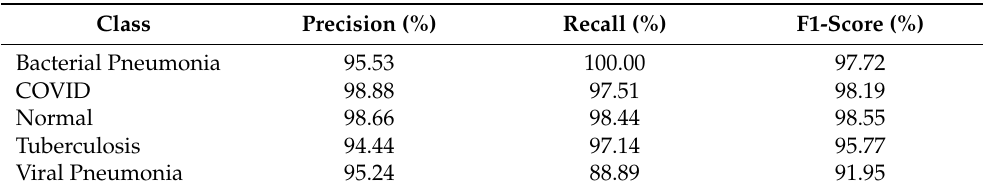
Table 3. The performance metrics (precision, recall and F-1 score) for each class for segmented chest X-ray images by the best performing Xception model.